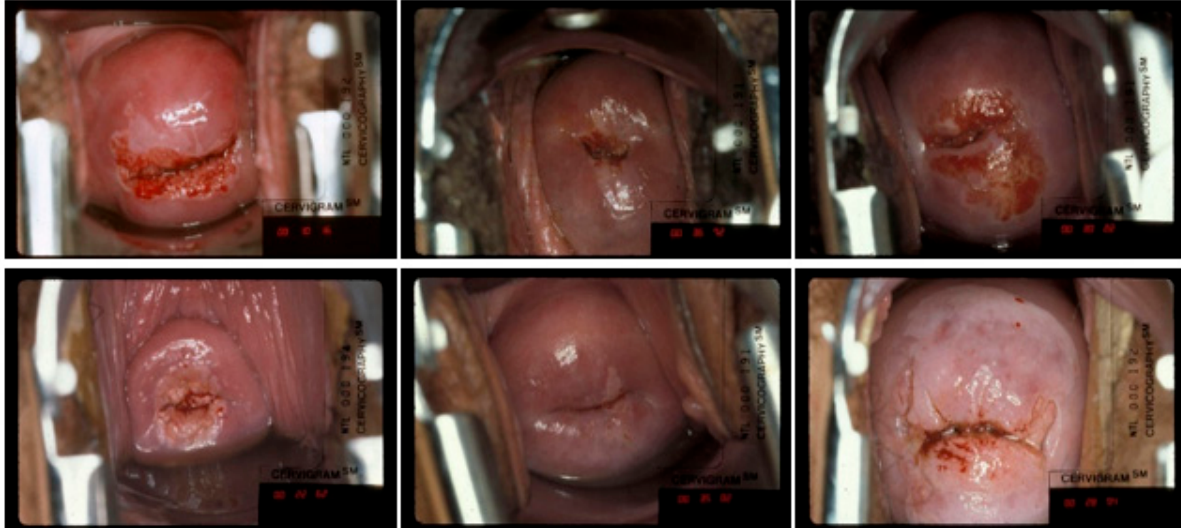
Figure 2. Examples of cervix images used in this study, the top row images are labeled as “treatable” and the bottom row images are labeled as “not treatable” (reasons for not treatable given by the expert: left—lesion in canal, middle—SCJ not visible, right—lesion too large for ablation).